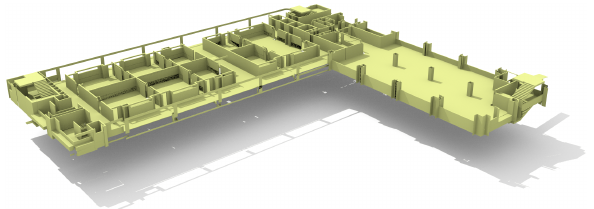
Figure 1. CityGML dataset obtained from IFC (storey of one building) with the approach developed within our project. Source of the input IFC dataset: BCA